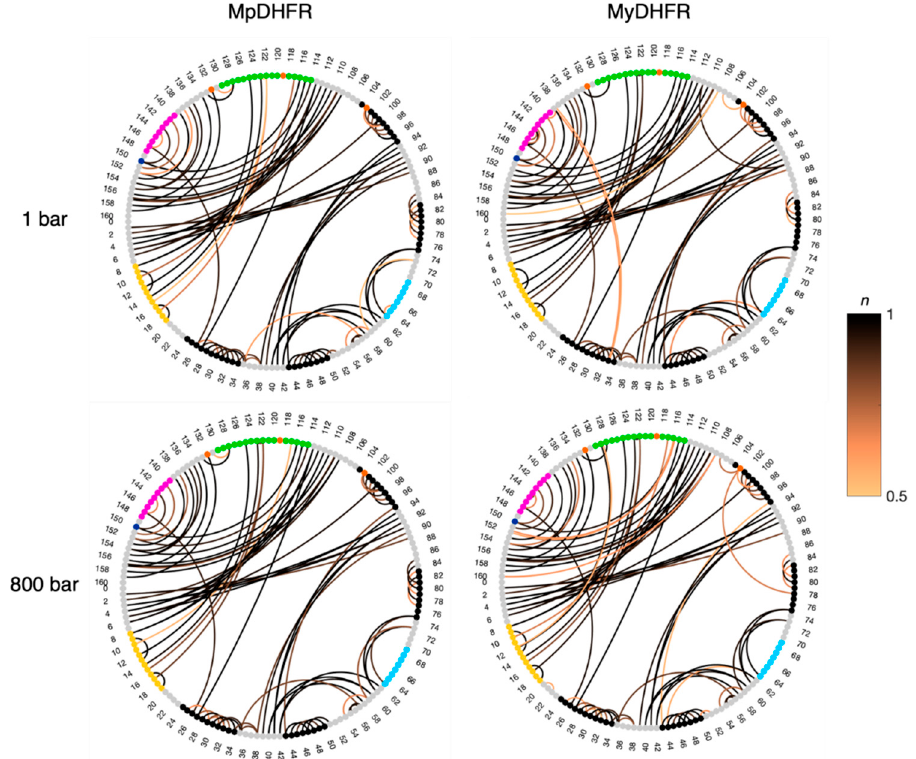
Figure 2. Hydrogen bond occupancy ( n ) for Moritella DHFRs at low and high pressure. Connections between donor/acceptor residues with n > 0.5 are shown with the line color proportional to the occupancy of the hydrogen bond. The unique residues for Mp- (dark blue) and MyDHFRs (orange) along with the α -helices (black), and Met20 (yellow), CD (cyan), FG (green), and GH (magenta) loops are identified on the nodes.